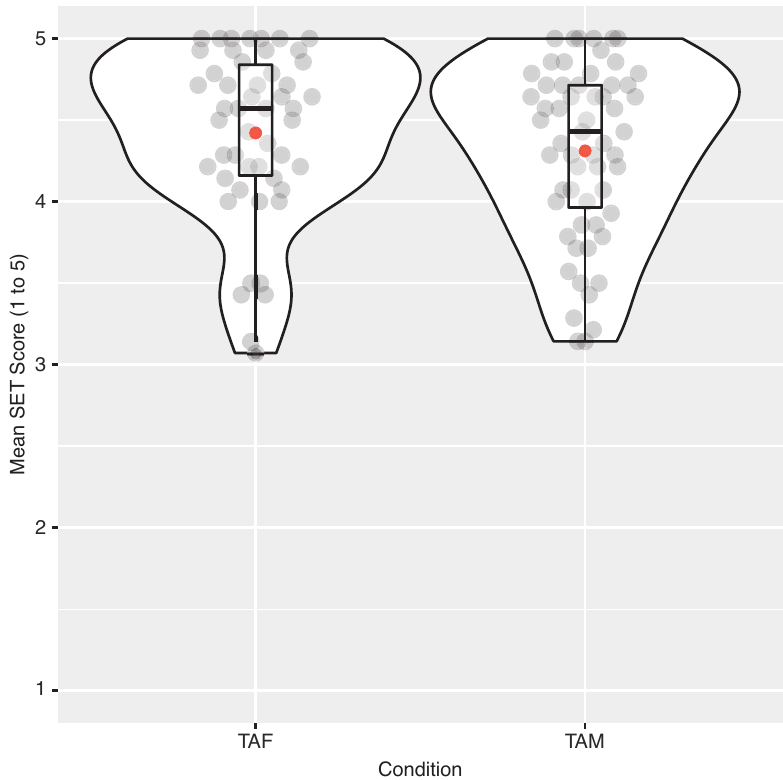
Figure 6. The violin plots of Khazan et al.’s recovered data on the original 1 to 5 Likert SET scale, for TAF and TAM conditions, with the six outliers removed. Both the mean and median ratings for the female TA are higher than for the male TA although not significantly